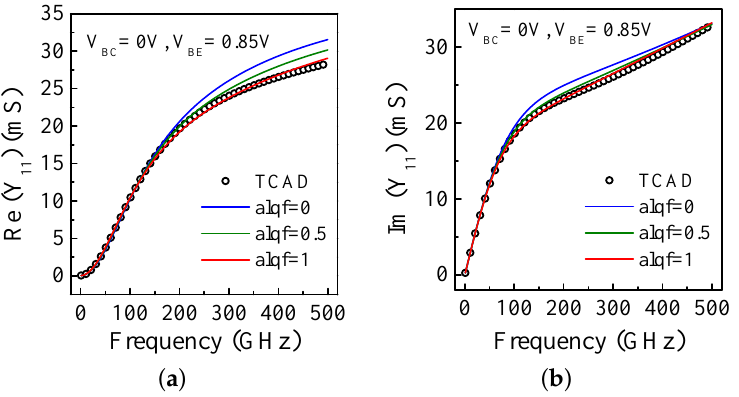
Figure 15. Sensitivity of alit on frequency dependent (cid:60) y 21 ( a ) and Phaseh 21 ( b ) for the 0.09 µ m × 4.8 µ m SiGe HBT biased at V BC = 0 V with V BE = 0.85 V: comparison between TCAD (circles) and Hicum L2v2.4 (solid line).